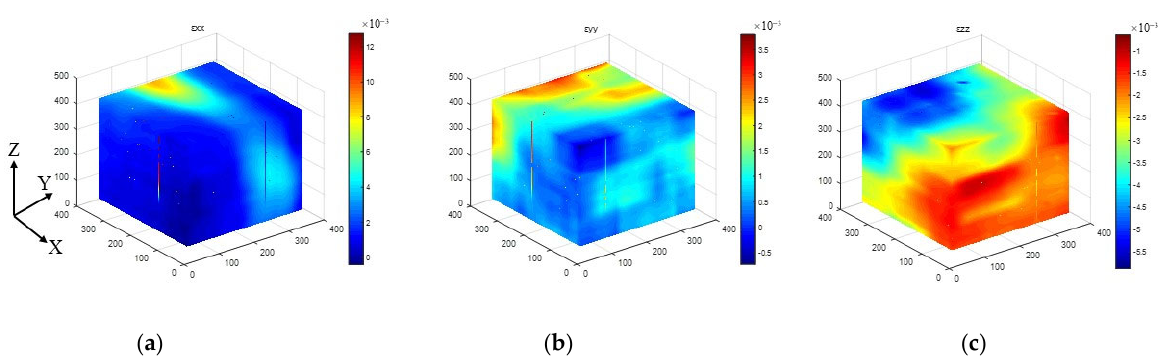
Figure 9. Strain fi elds of cement mortar under 30 MPa. ( a ) ε xx , σ = 30 MPa; ( b ) ε yy , σ = 30 MPa; ( c ) ε zz , σ = 30 MPa.